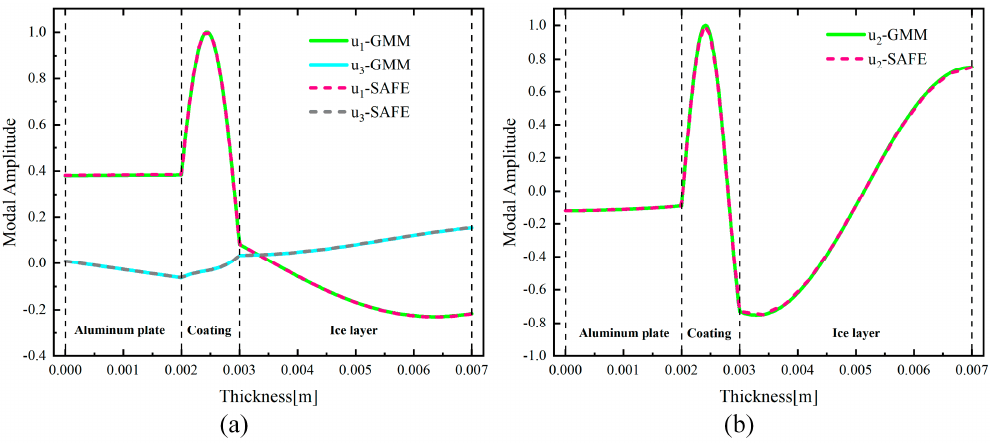
Figure 3. Wave structures of ( a ) S 1 mode at 200 kHz; ( b ) SH 3 mode at 300 kHz.